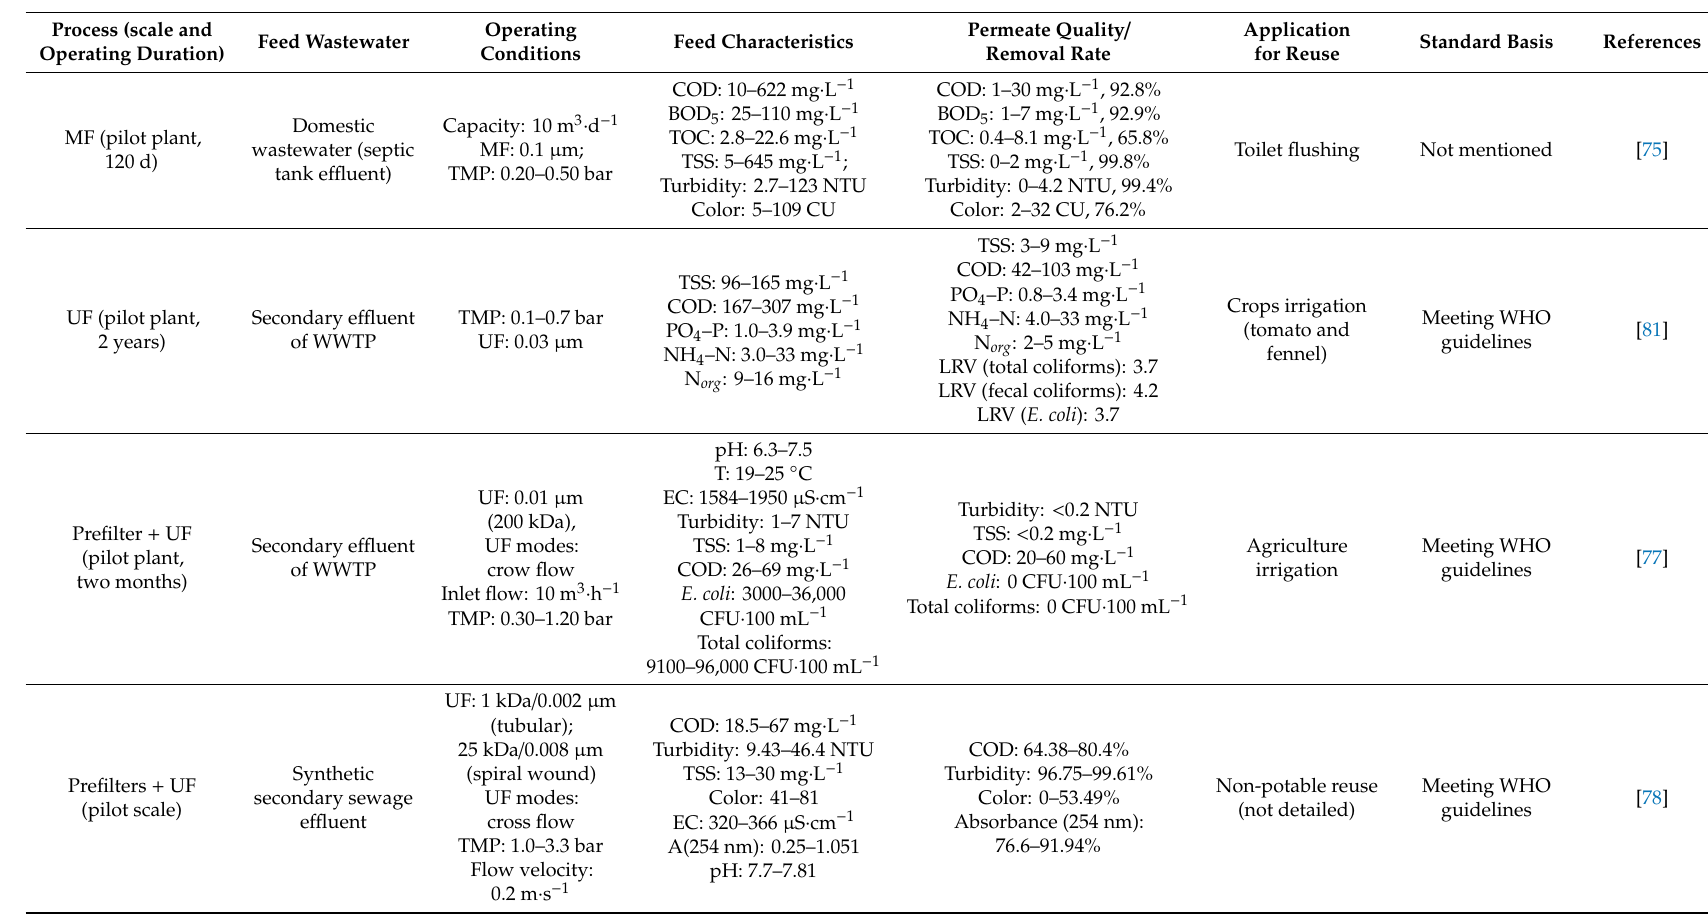
Table 6. Microfiltration (MF) / ultrafiltration (UF) processes alone after secondary treatment for water reuse